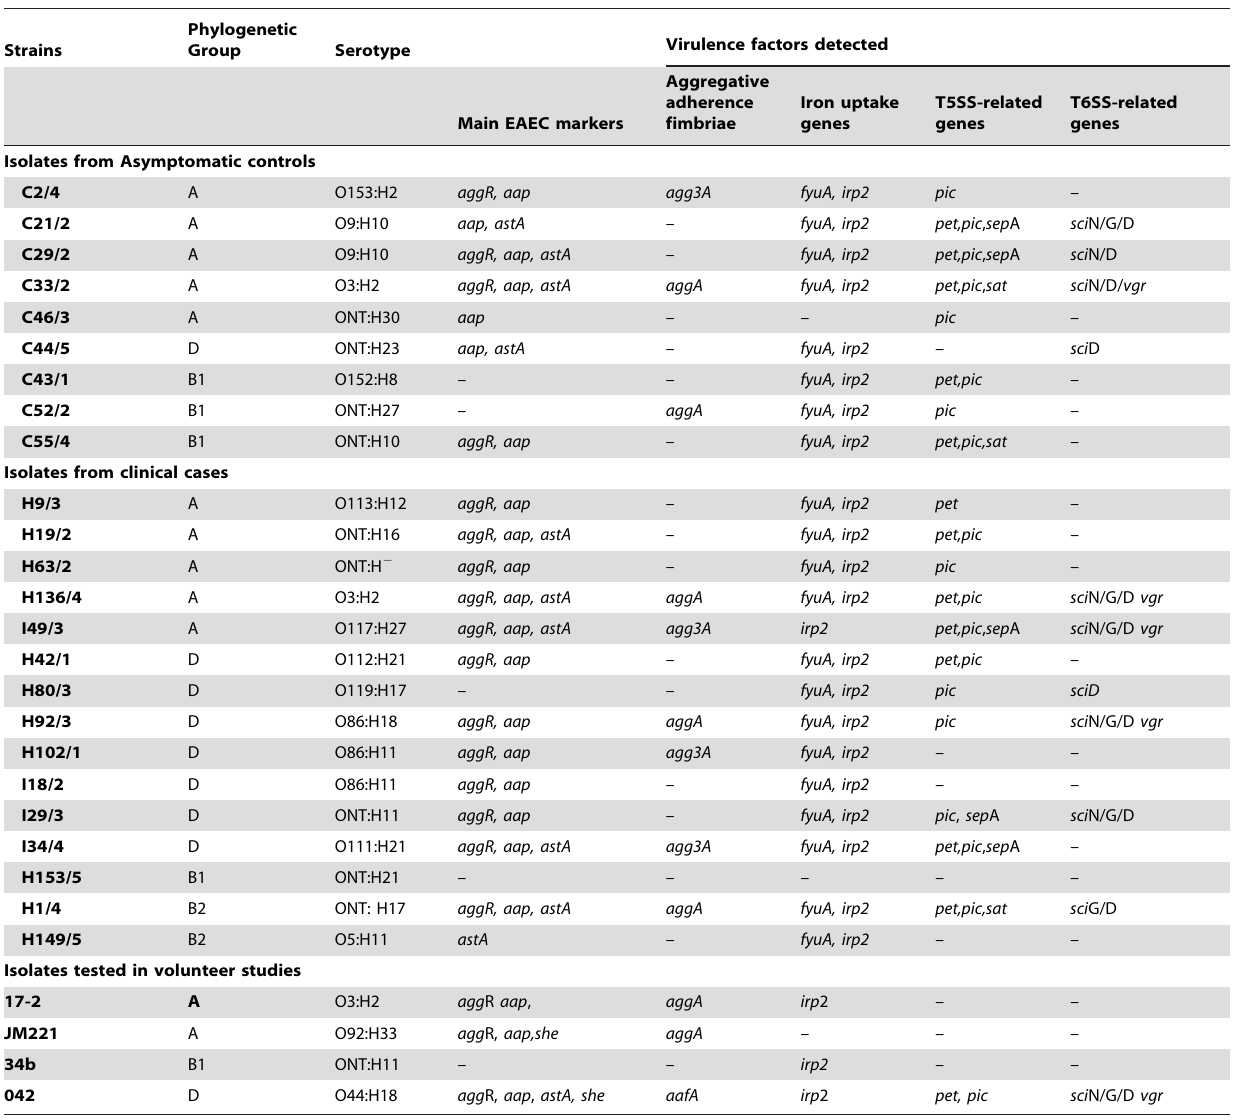
Table 1. Genetic attributes of EAEC